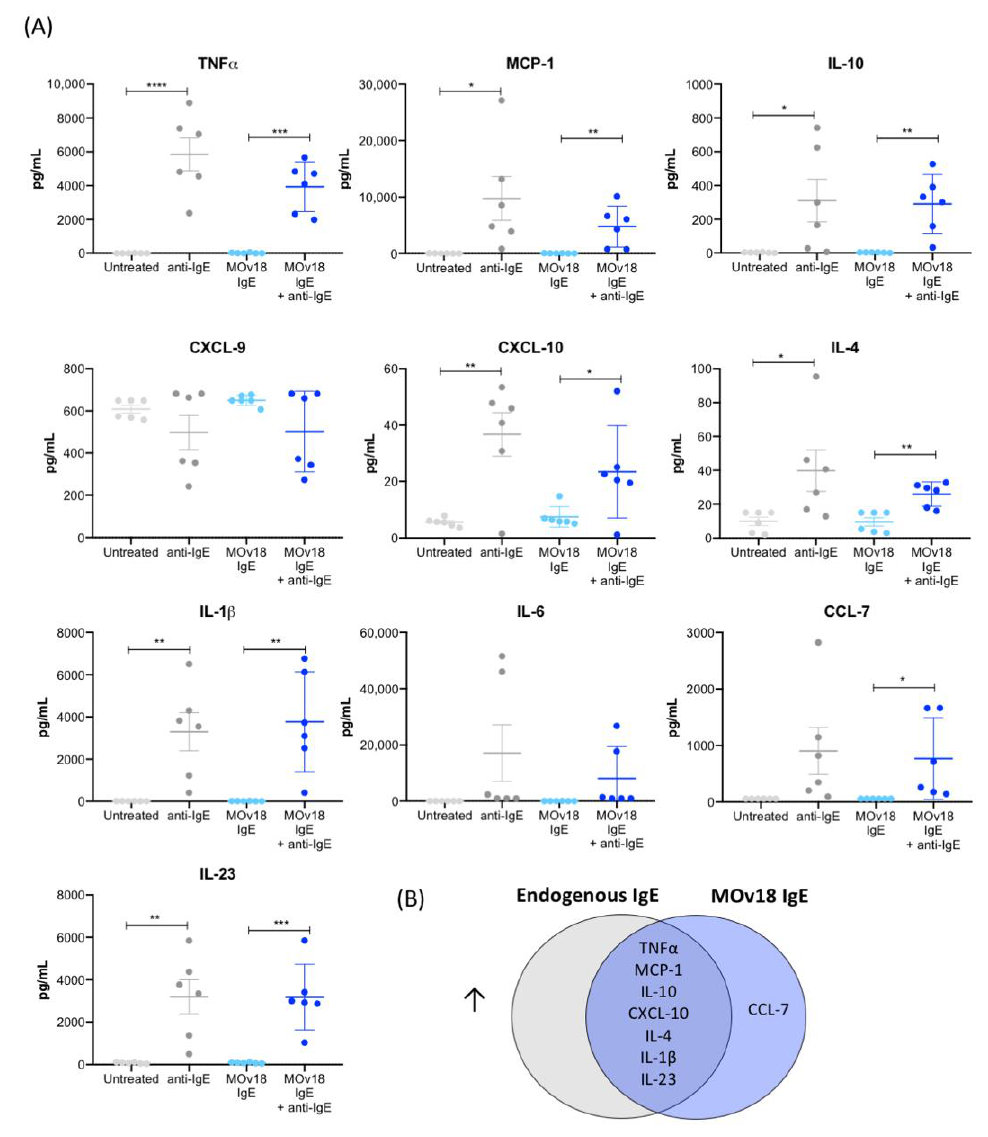
Figure 2. IgE cross-linking on the surface of monocytes triggers increased pro-inflammatory cytokine and chemokine release. ( A ) Cytokine and chemokine production measured in cell culture supernatants following cross-linking of IgE on the surface of primary monocytes isolated from healthy volunteer blood ( n = 6). ( B ) Venn diagram of the cytokines and chemokines that were significantly upregulated upon cross-linking of endogenous or MOv18 IgE, or both. Error bars represent standard error of mean (SEM) (independent experiments). A one-way ANOVA with Tukey’s post-hoc test was performed to assess significance (* p < 0.05; ** p < 0.01; *** p < 0.001; **** p < 0.0001). Together, these findings suggest that IgE stimulation on human monocytes triggered release of pro-inflammatory mediators (TNF α , MCP-1, IL-10, CXCL-10, IL-4, IL-1 β and IL-23) (Figure